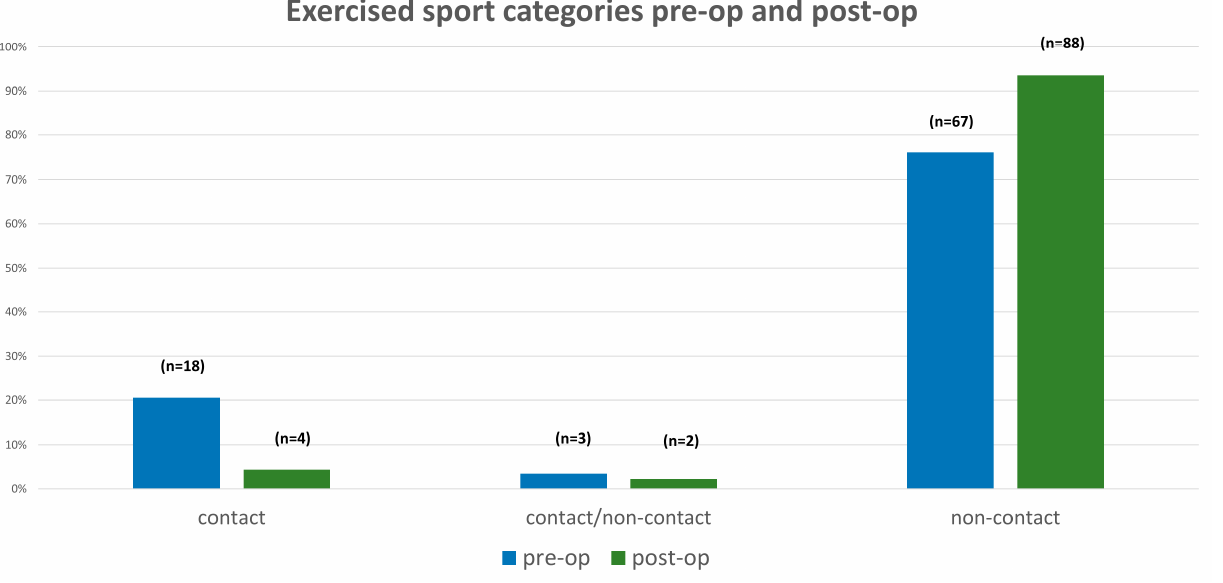
Figure 4. Diagram with an illustration of the exercised sports categories pre- and